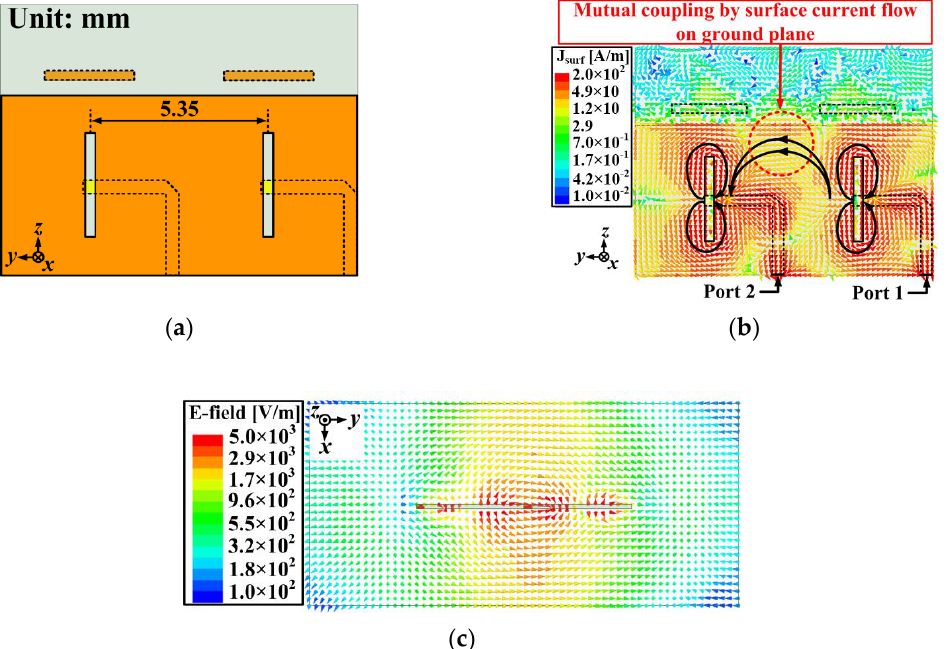
Figure 9. The 1 × 2 array antenna without slits: ( a ) top view, ( b ) simulated surface current distribution at 28 GHz, and ( c ) simulated E-field distribution in the E-plane at 28 GHz.